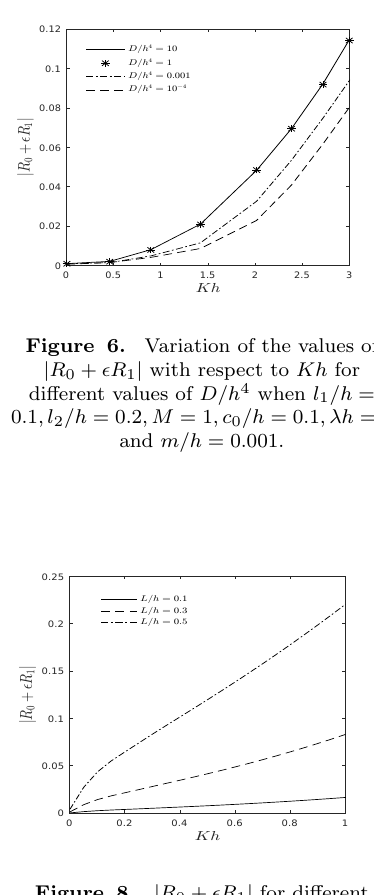
Figure 8. | R 0 + (cid:15)R 1 | for different plate lengths with M = 1 ,c 0 /h = 0 . 1 ,l 1 /h = 0 . 01 ,D/h 4 =